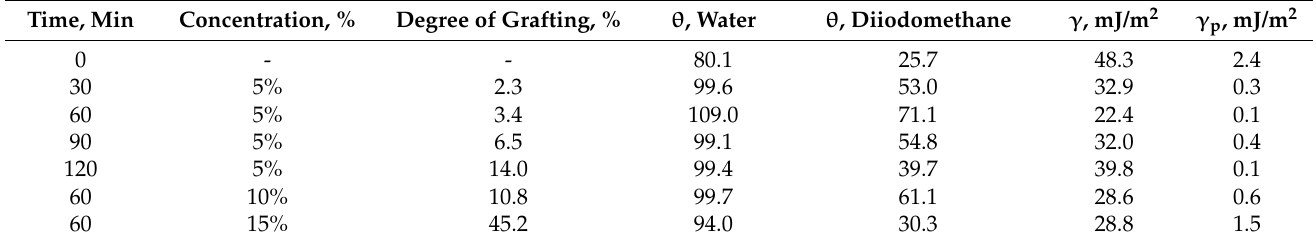
Table 2. Change in the contact angle and surface free energy contributions of membranes as a function of the time of UV irradiation and concentration of monomer (pore diameter of pristine PET TeMs is 3.05 µ m, pore density is 1 × 10 6 pore/cm 2